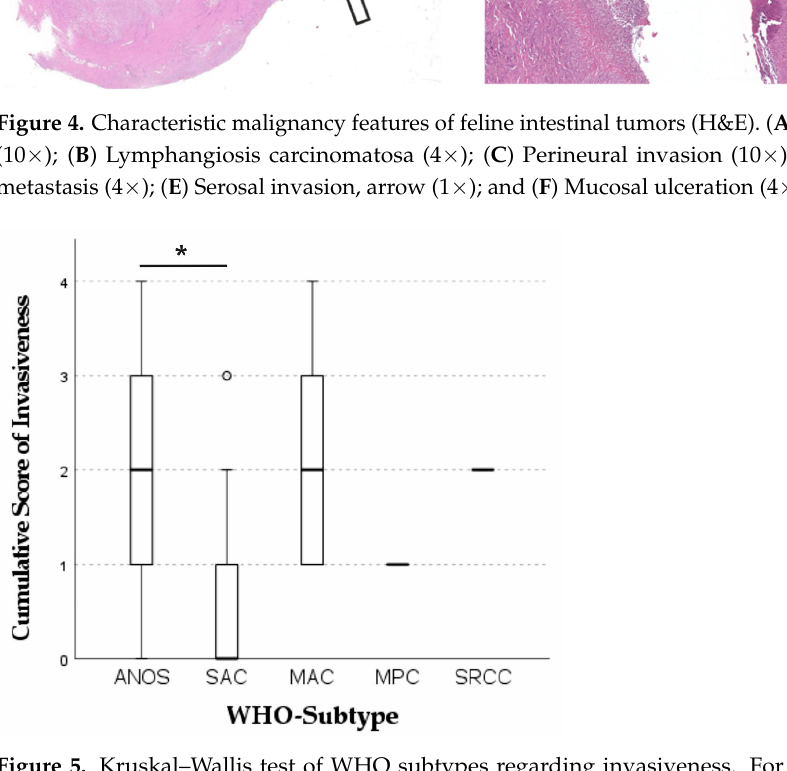
Figure 5. Kruskal–Wallis test of WHO subtypes regarding invasiveness. For the overall cohort, statistical analysis revealed a significant difference between the WHO subtypes regarding the feature invasiveness, represented by a cumulative score of invasiveness (vascular (1), perineural (1), lymphatic (1) and serosal invasion (1), max. score of 4). ( p = 0.021). The score of invasiveness was significantly higher for ANOS than for SAC (* p =